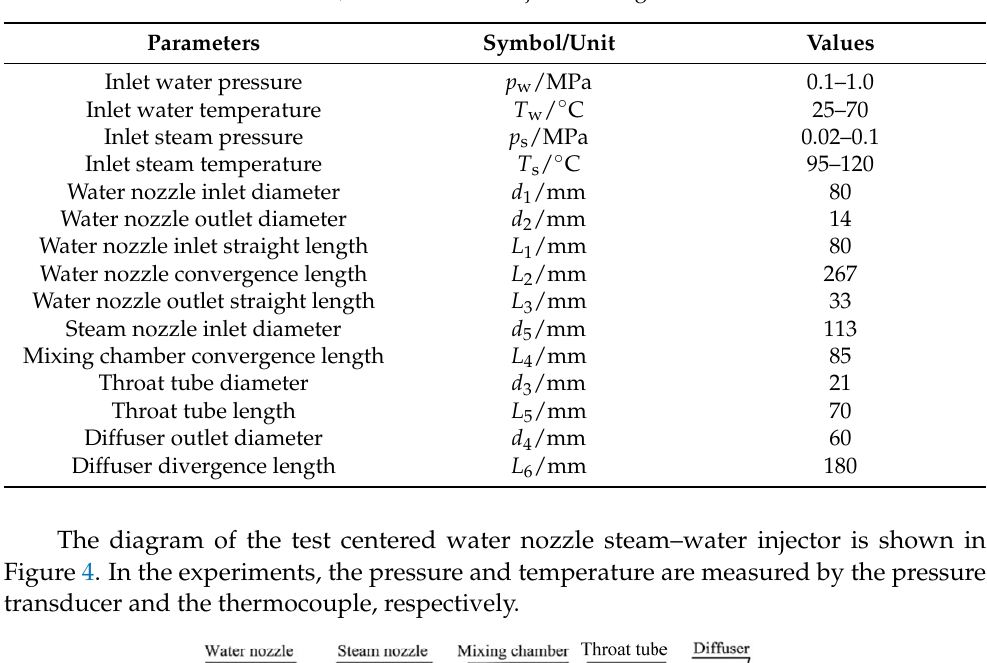
Table 2. Parameters of steam inlet, water inlet and injector configuration.